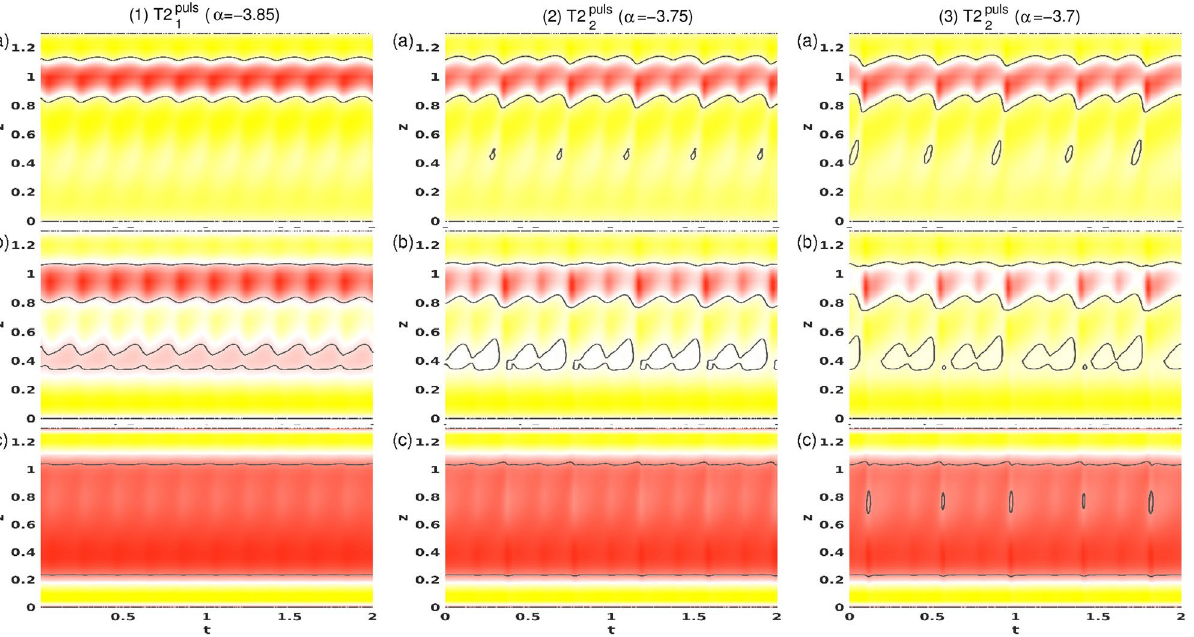
puls α 3.85 , ( 2 ) α 3.75 , and T2 puls 1 at ( 1 ) 2 at ( 3 ) = − = − r 1 d / 4 , (b) r r 1 d / 2 , = + = +